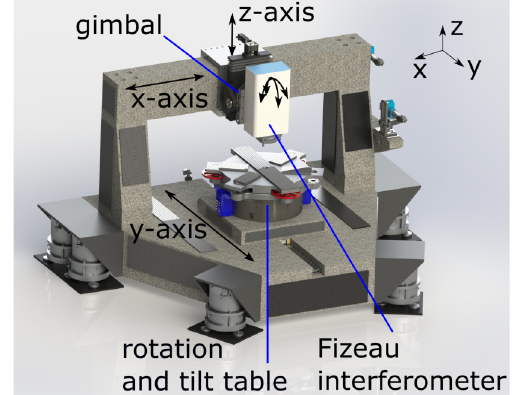
Figure 1. Mechanical setup of the measurement system under development: The arrows represent the possible movements of the Fizeau interferometer and the specimen. The specimen (not shown) is placed on the rotation and tilt